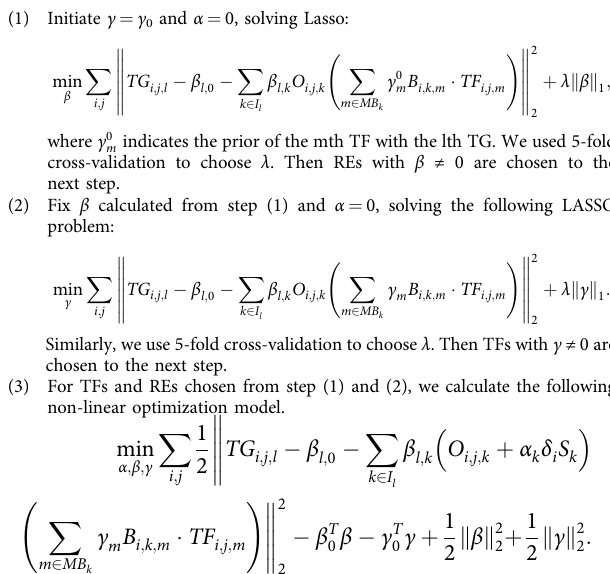
ATAC-seq samples in our hypoxia induction experiment. For all 50 samples, we calculate the average FE score along 5 samples under each condition (within one population in one-time point) (Supplementary Fig. 4b), where each line represents the FE score of one population in one particular time point under changes of selection cutoff. Then if the FE scores are averaged by time points (each time contains 10 samples, ignoring population difference), we obtain the fold enrichment changes under normoxia (0 h) and hypoxia (6h) (Fig. 1f).